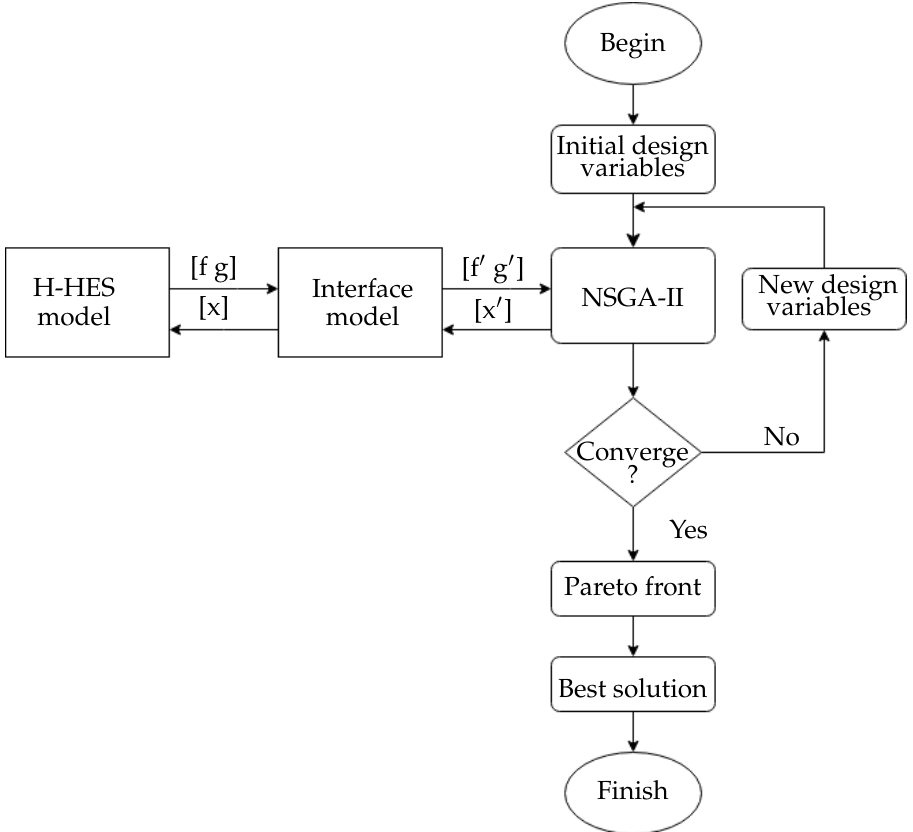
Figure 6. Optimization process flowchart of the H-HES model.